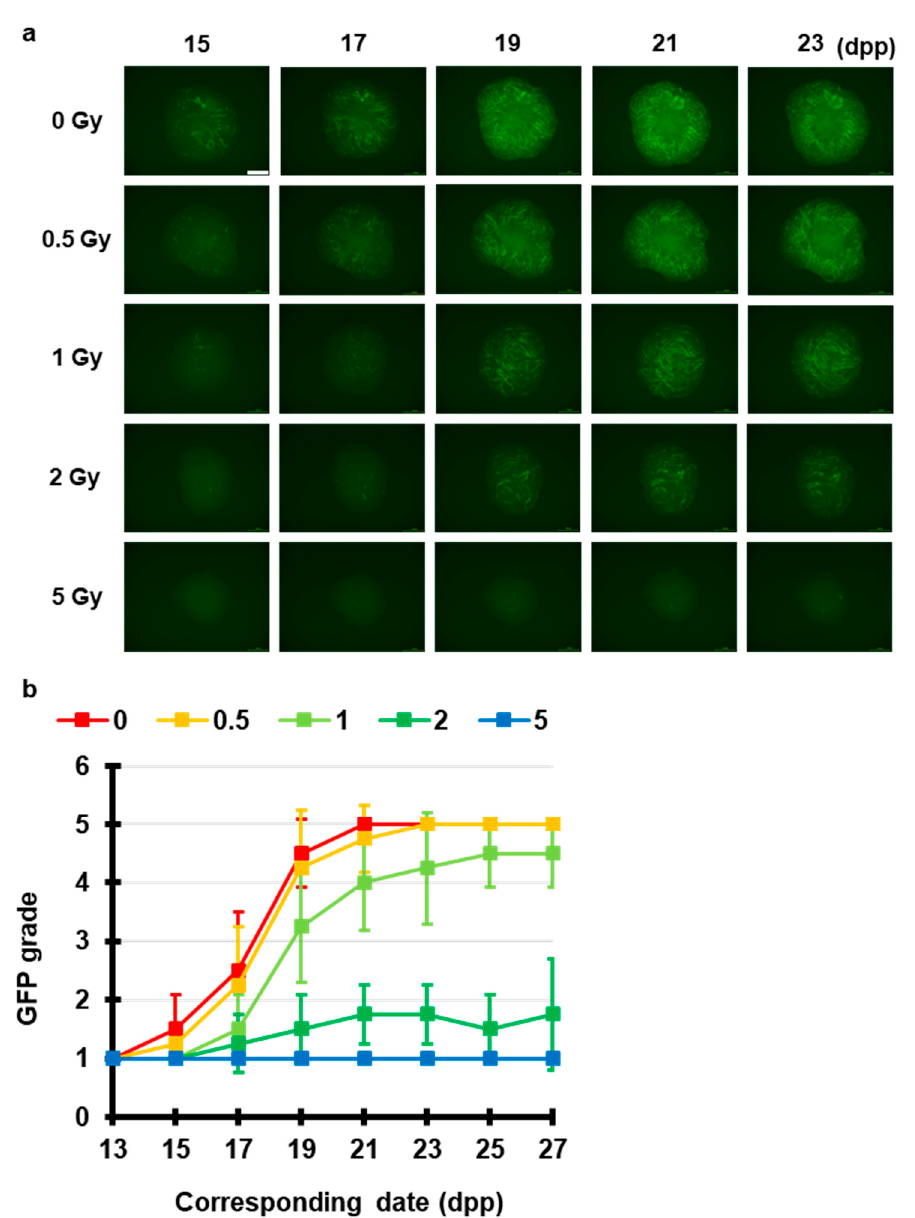
Figure 2. Chronological Acr-GFP expression changes after exposure to X-rays. ( a ) Representative images show Acr-GFP expression obtained at 15–23 dpp in single cultures following exposure to 0 (control), 0.5, 1, 2, and 5 Gy conventional X-rays (150 keV). Scale bar, 500 µ m. ( b ) Evaluation of Acr-GFP expression from 13 to 27 dpp. Single tissue samples from each mouse testes were randomly assigned to experimental groups. At least four tissue samples each from di ff erent donor mice were used for each experiment; contaminated samples were excluded. Data show the mean Acr-GFP expression ± SD. There was statistically significant di ff erence between group means ( p < 0.01).